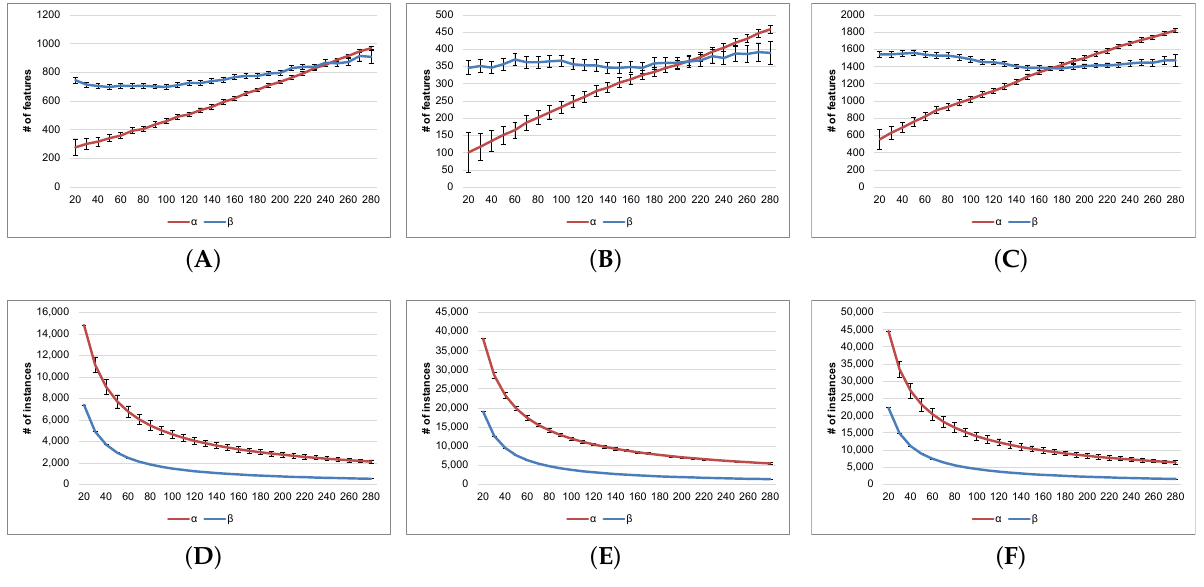
Figure 2. The number of determined DWT attributes and instances ± SEM depending on the window ( α ) and step ( β ) sizes. x -axis indicates the size of either α or β . ( A ) NSLKDD; ( B ) Kyoto2006; ( C ) CICIDS2017; ( D ) NSLKDD; ( E ) Kyoto2006; ( F )